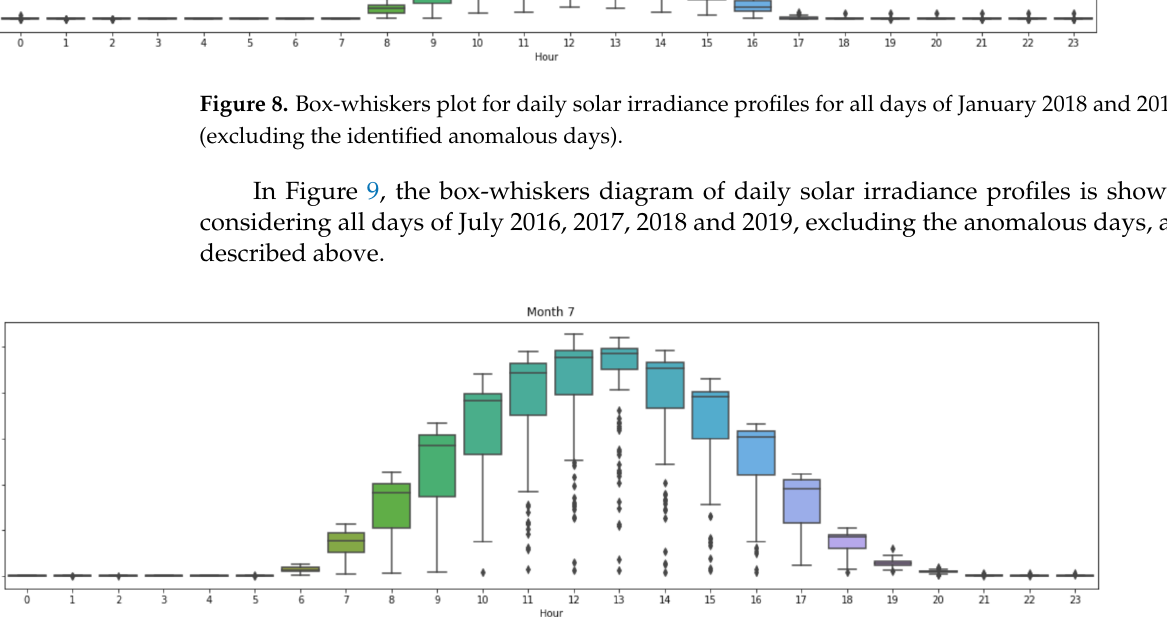
Figure 9. Box-whiskers plot for daily solar irradiance profiles for all days of July 2016, 2017, 2018 and 2019 (excluding the identified anomalous